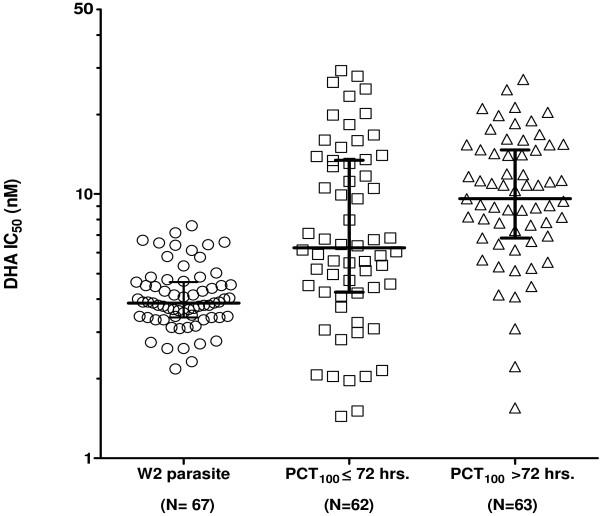
IC50values of DHA against clinical Plasmodium falciparum field isolates collected from a drug-resistant area in Cambodia (middle and right hand columns), compared to the W2 parasite used as a reference clone (left hand column).Median and interquartile ranges are shown. Median IC50s of DHA were significantly higher for patients with PCT100 >72 hours (9.6 nM) than PCT100 ≤72 hours (6.3 nM, p = 0.0134), and both were significantly higher than the reference W2 clone (3.9 nM, p < 0.0001).